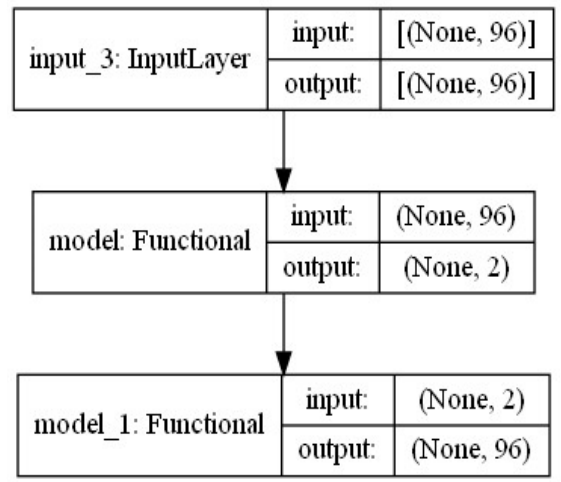
Figure 2. Structure of the autoencoder model.